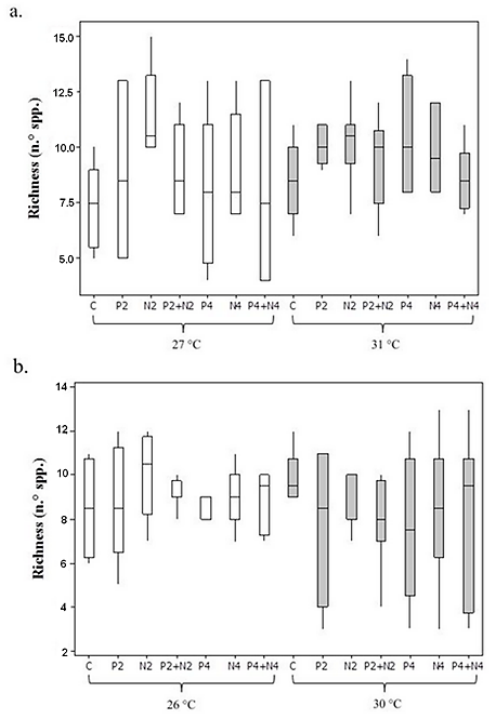
Figure 1. Variation (medians and quartiles, n = 8) of the total biomass (mg L -1 ) in different nutritional enrichment and temperature treatments, for the rainy season (a) and dry season (b). White bars represent the temperature control treatments and the ashes the warming temperature treatments.